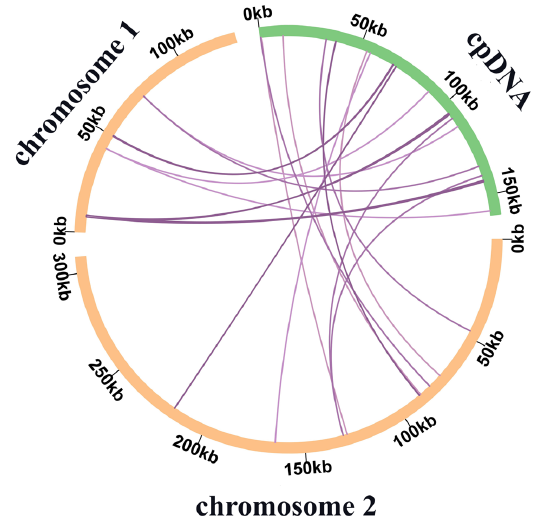
Figure 4. Schematic of 18 MTPTs of C. speciosa . MTPTs 1-10 were found in chromosome 1, and MTPTs 11-18 were found in chromosome 2. Table S1 presents the detailed data for 18 MTPTs.